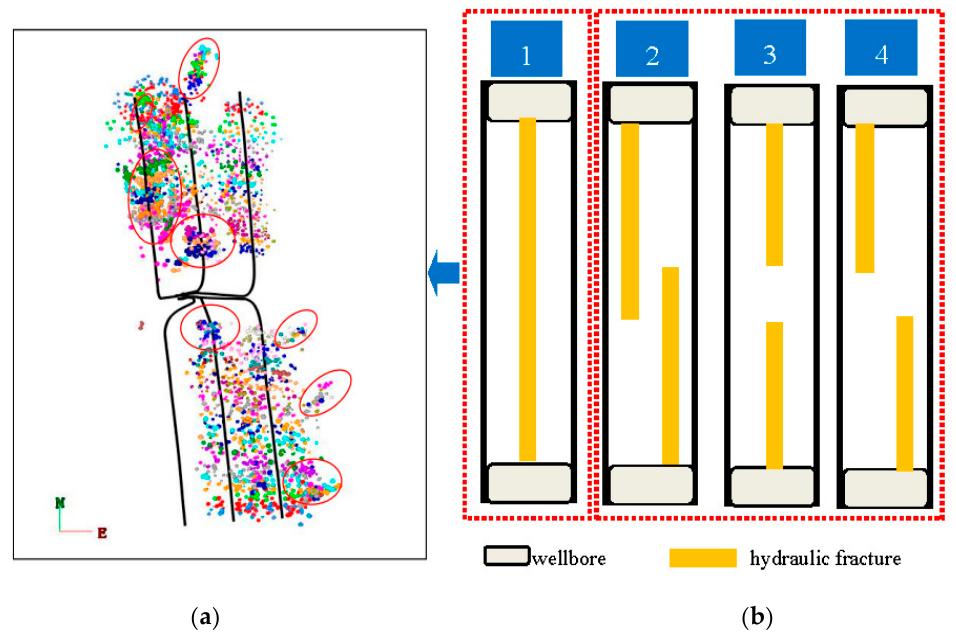
Figure 2. The schematic illustration of a MWP scheme in a shale gas reservoir: ( a ) Microseismic monitoring map; ( b ) The distribution of HFs.